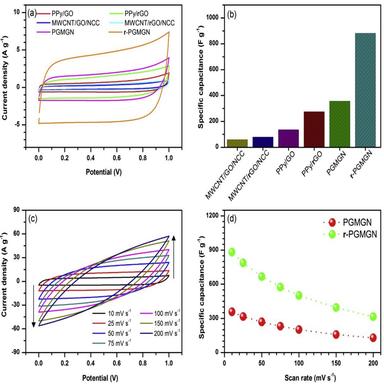
A comparison of (a) CVs, and (b) the specific capacitance of symmetrical supercapacitor devices for PPy/GO, PPy/rGO, MWCNT/GO/NCC, MWCNT/rGO/ NCC, PGMGN and r-PGMGN at 10 mV s−1 , (c) CVs of r-PGMGN at different scan rates and (d) the comparison of specific capacitance of PGMGN and r-PGMGN at different scan rates.